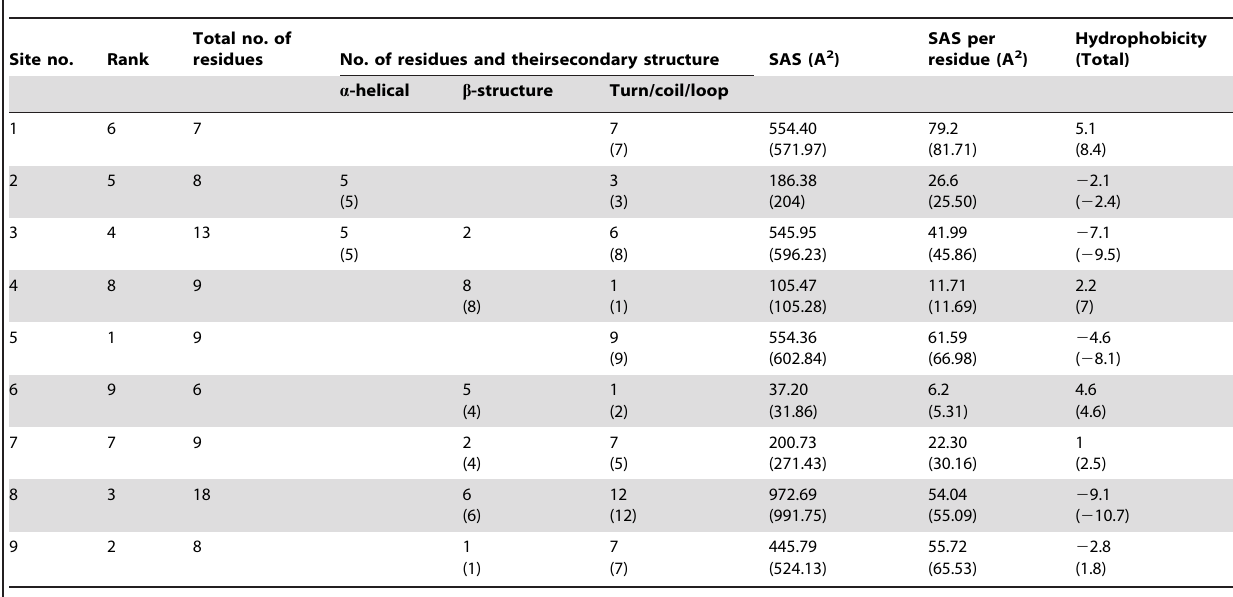
Table 3. Structural characteristics of conserved regions/sites.